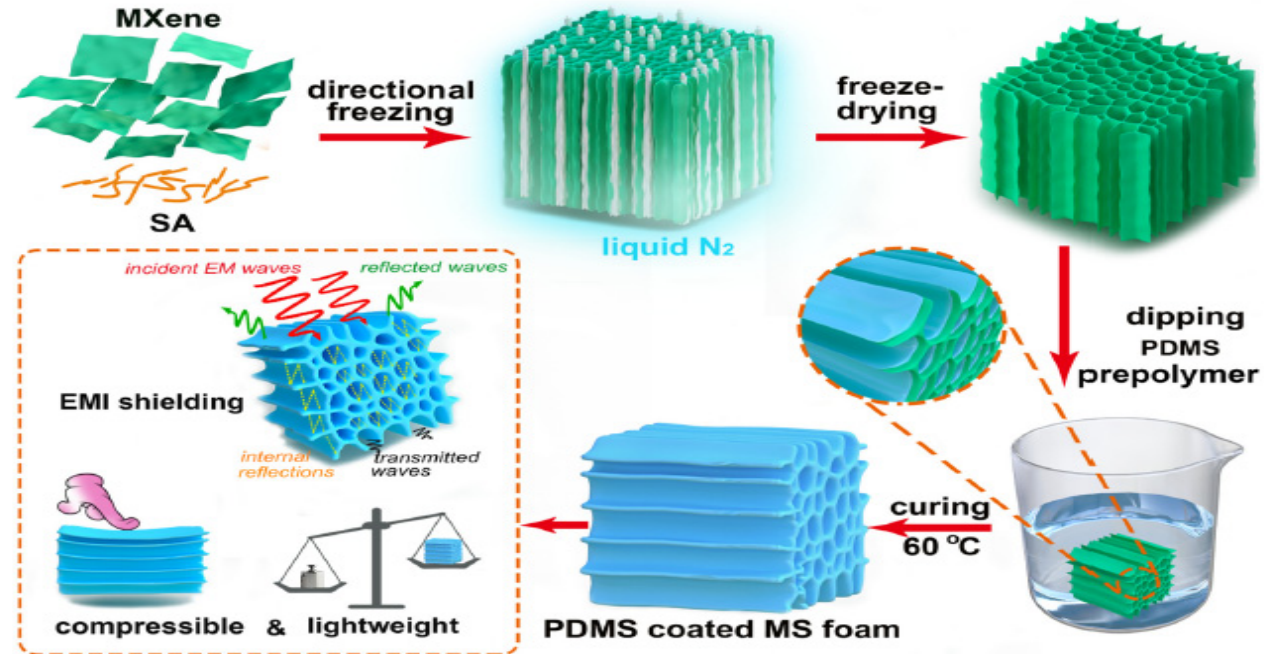
Figure 20. Schematic representing the fabrication of MXene/sodium alginate aerogel and its PDMS- coated foam. Reproduced with permission from [164]. Copyright 2020, Elsevier Ltd.